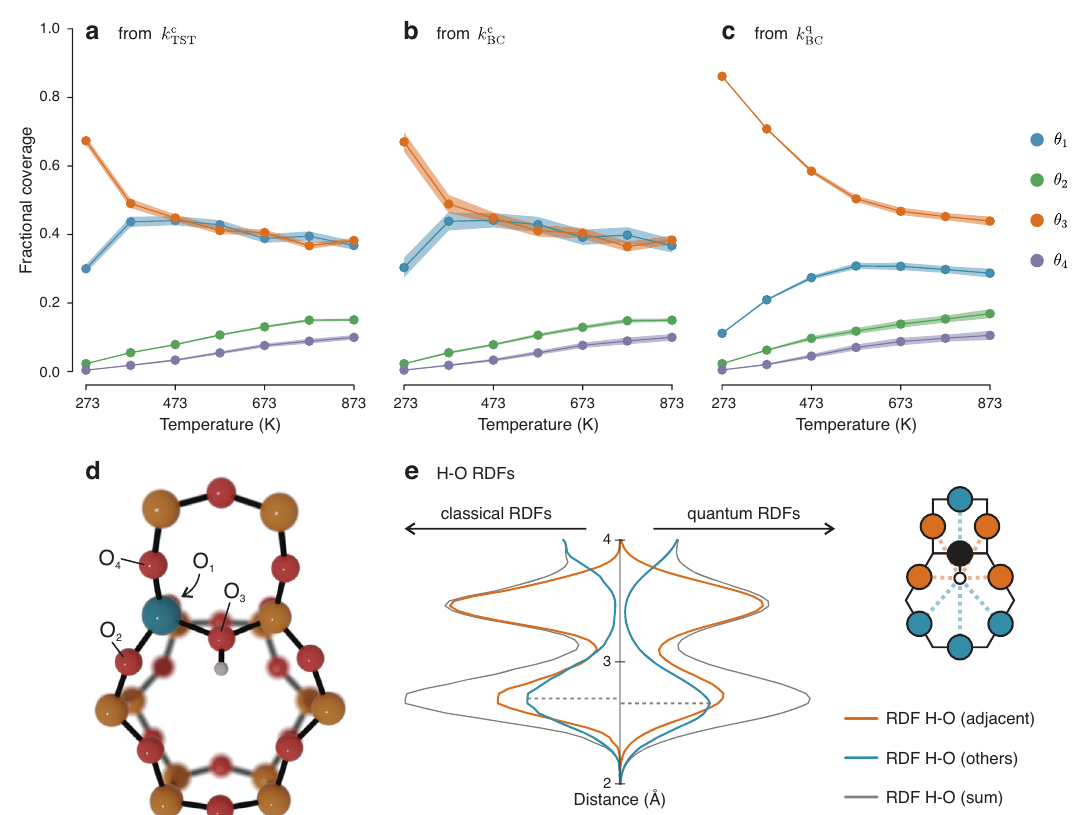
Fig. 6 | Including NQEs can change the computed equilibrium proton cov- erages.a – c Equilibriumcoverages( θ i )ofthe4oxygensitesaroundtheAldefectas function of temperature, computed from the k c TST , k c BC an d k q BC kinetic constants. d Portion of the H-CHA framework as seen along the c cell vector, showing the optimized structure of the BAS on O 3 . Si is depicted in yellow, O in r e d, Al in blue